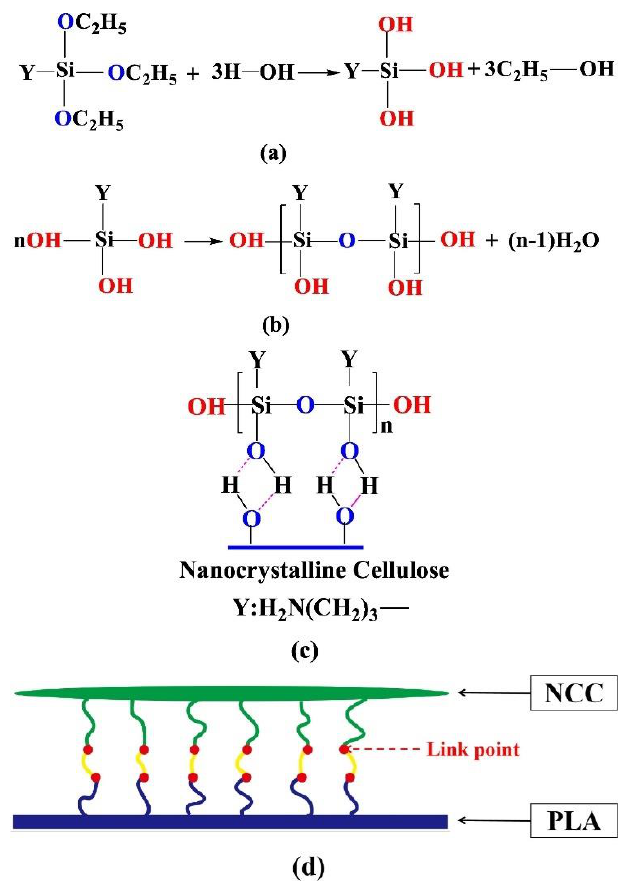
Figure 4. Proposed alkylation mechanism of NCC ( a ) Hydrolyzed of KH-550, ( b ) Oligomers for- mation, ( c ) Formation of hydrogen bond on surface of NCC ( d ) Coupling of KH-550 and NCC [57]. A comparison is made between two different methods of silylation using vapor tech- cellulose fiber with hexamethyldisilazane (HDMS) under the chemical vapor condition, the hydroxy group is converted to trimethylsiloxy group, which imparts